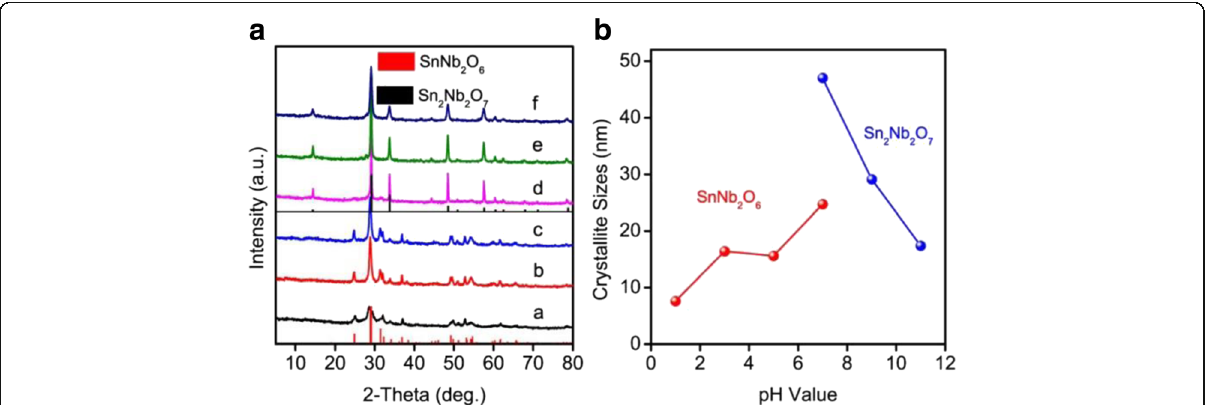
Fig. 1 X-ray diffraction patterns of tin niobate prepared in different pH value of the reaction solution (1~ 11) ( a ). Vertical bars below the patterns represent the standard diffraction data from JCPDS files for SnNb 2 O 6 (01-084-1810) and Sn 2 Nb 2 O 7 (00-023-0593). Relationship between the crystallite sizes and pH value of the reaction solution ( b